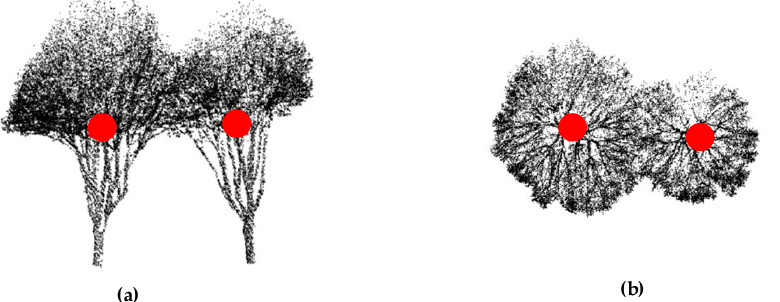
Figure 4. Crown center from different views. ( a ) Front view of crown center. ( b ) Top view of crown center. The red dots represent the crown center.